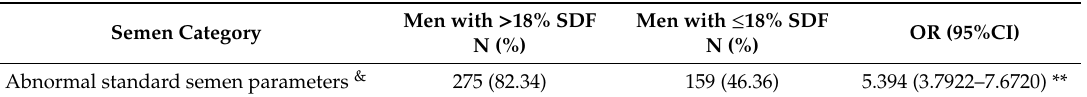
Table 3. Odds ratio (OR) for abnormal standard semen parameters in men with > 18% SDF (n = 334) compared to men with ≤ 18% SDF (n = 343).